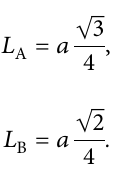
0.75 Zn 0.25 Fe 2 O 4 and Ni 0.25 Zn 0.75 Fe 2 O 4 at the temperature of (a) 500